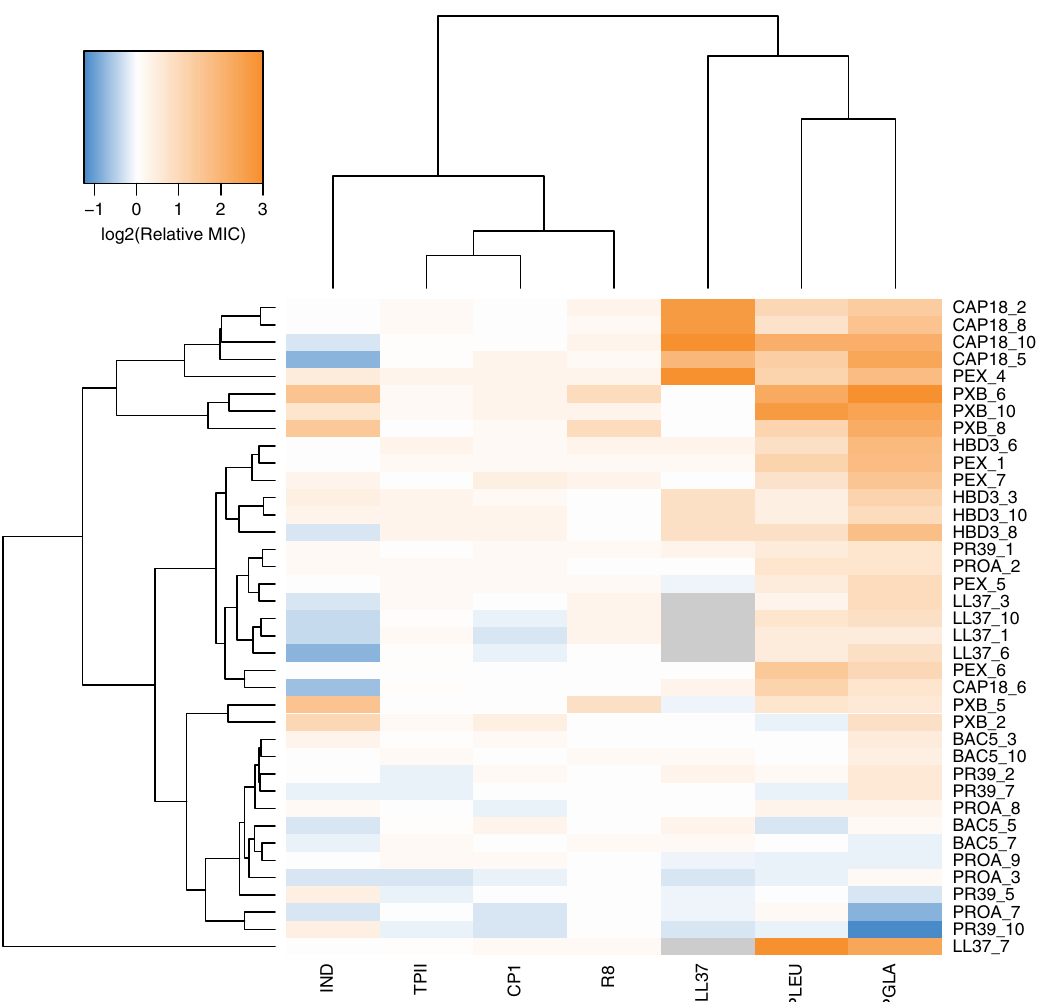
Fig. 3 Cross-resistance of AMP-resistant lines towards a set of 7 AMPs. Relative minimum inhibitory concentration (MIC) was calculated as the ratio of the MIC of the resistant line and the sensitive wild-type strain. Hierarchical clustering was performed separately on rows and columns, using complete linkage method with Euclidean distance measure on the raw MIC data. Throughout the fi gure, blue coloring refers to collateral-sensitivity (MIC at least two-fold lower than the wild-type), orange coloring refers to cross-resistance (MIC at least two-fold higher than the wild-type), white coloring refers to no or minimal change in susceptibility (MIC in between). Gray coloring refers to not applicable. AMP-resistant lines (rows) are named after the AMP it has been exposed to during the evolutionary experiment, and the serial number of the corresponding population. For relative MICs, see Supplementary Data 4 and for AMP abbreviations, see Supplementary Table 1. Data in this fi gure are representative of at least two biological